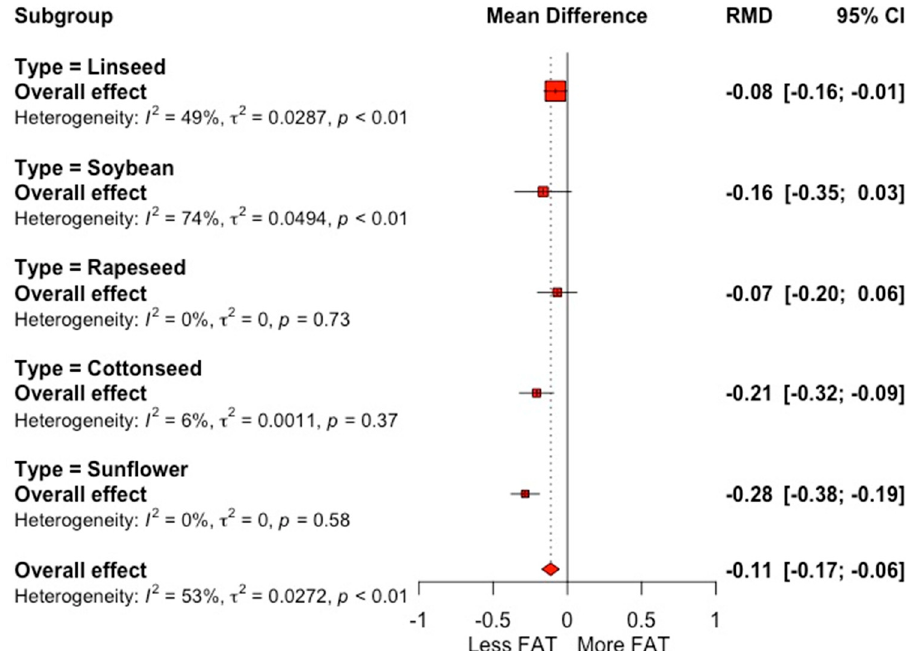
Figure 2. Forest plot of fat content (g 100 g − 1 ) for trials with the inclusion of oilseeds in dairy cow diets, grouped by type of oilseed. Point size reflects the relative weighting of the study to the overall effect size estimated, where a larger point size represents a greater weight and the combined effect size estimated, including the confidence intervals. The diamond represents the overall effect. RMD, raw mean difference.